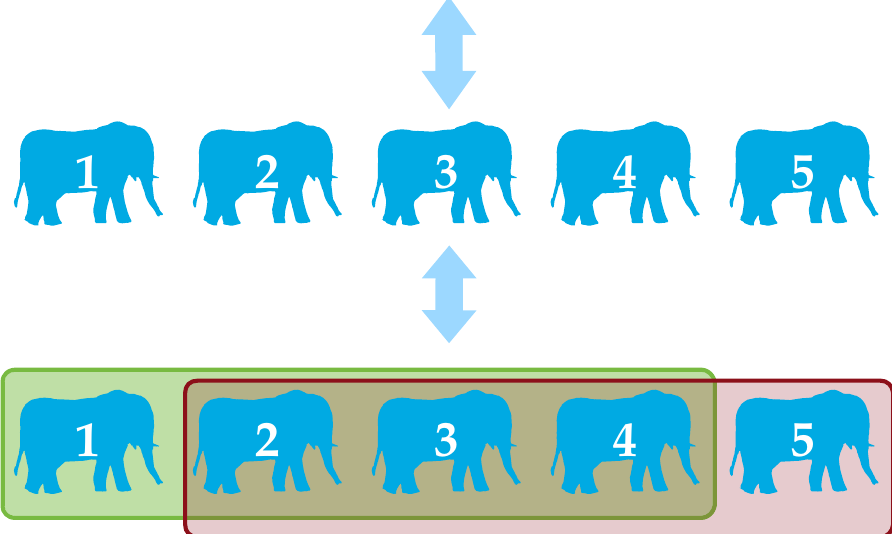
Fig. 3 Local translation invariance. A necessary condition from the requirement that the entire system is states are shown in Fig. 3 as green and red rectangles. For any contiguous subset of ε of length l , the marginals/reduced states are said to be locally translation-invariant (LTI) if